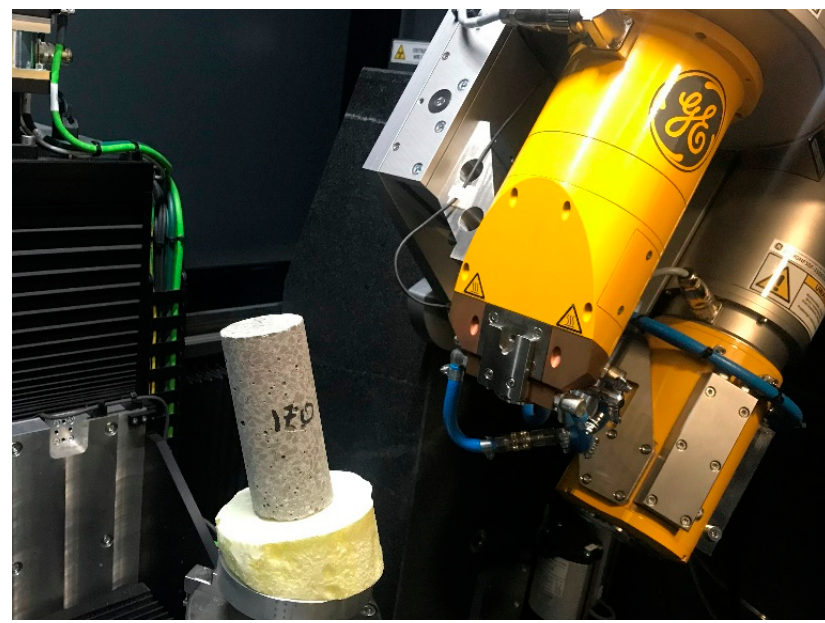
Figure 3. CT scanning. Figure 3. CT